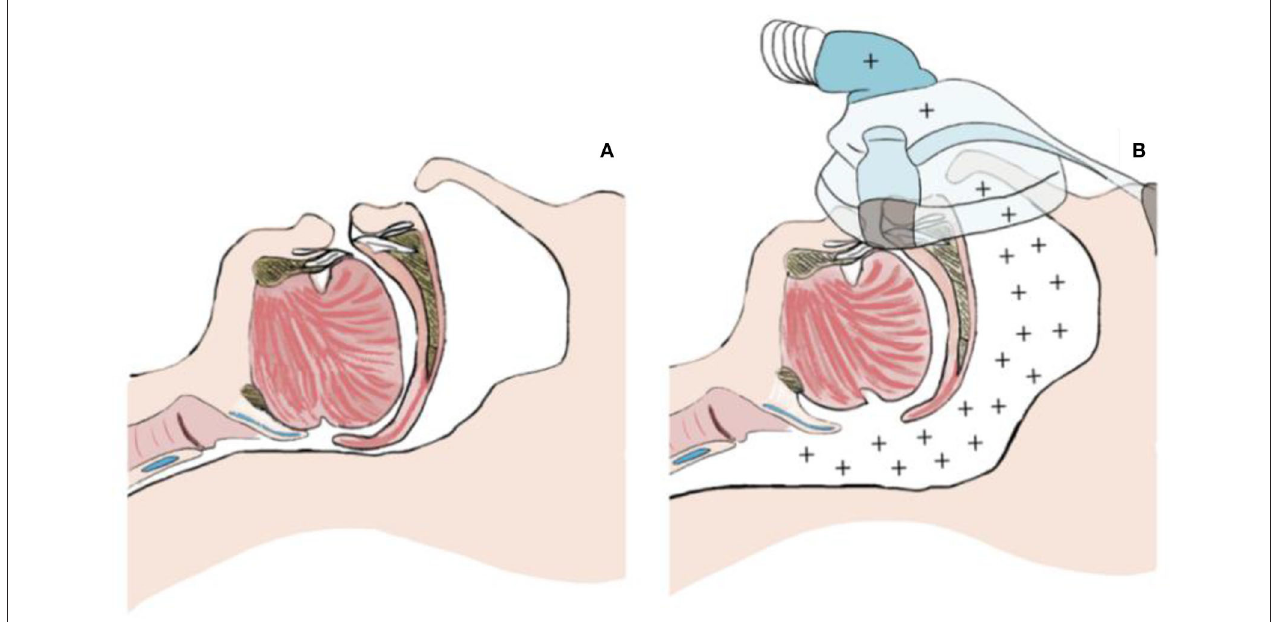
prevent rebreathing and a bias flow of oxygen for periods of zero CPAP flow is added to the set-up after the pneumotachometer and before the CPAP device (12,